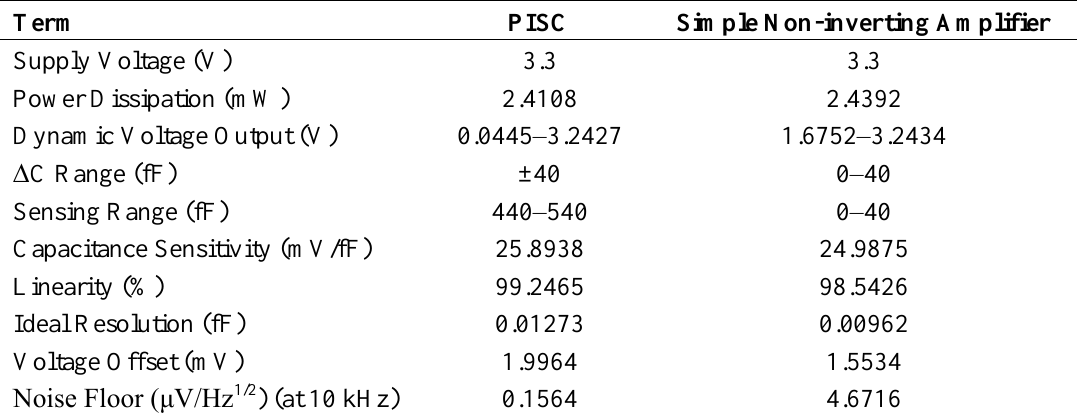
= 540 fF (25 °C), Frequency = 10 kHz). Gyro